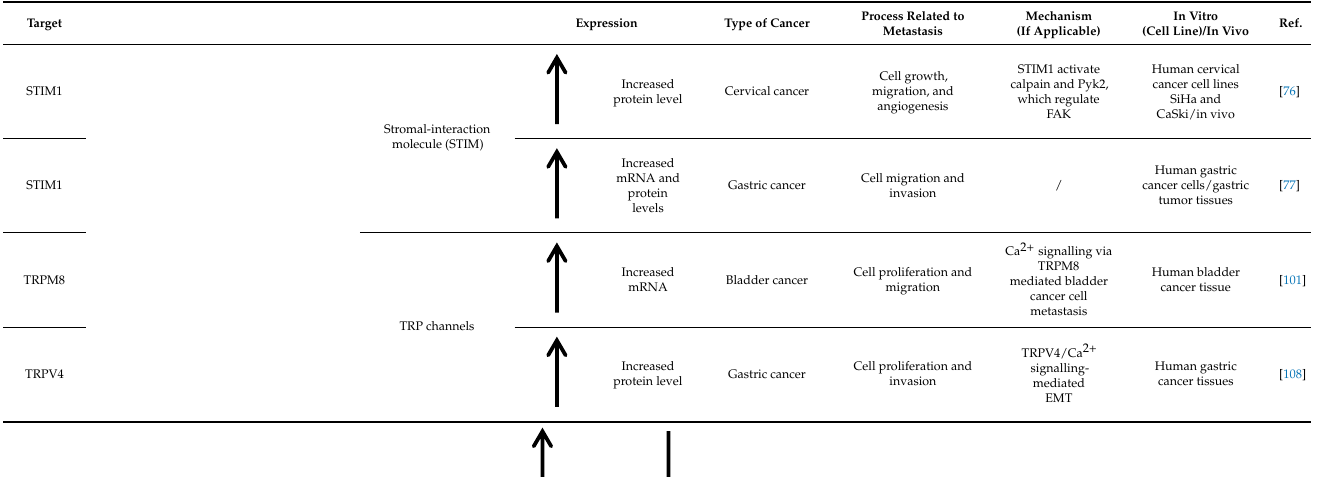
Table 1. Some experimental evidence supporting Ca +2 signalling-mediated cancer metastasis.